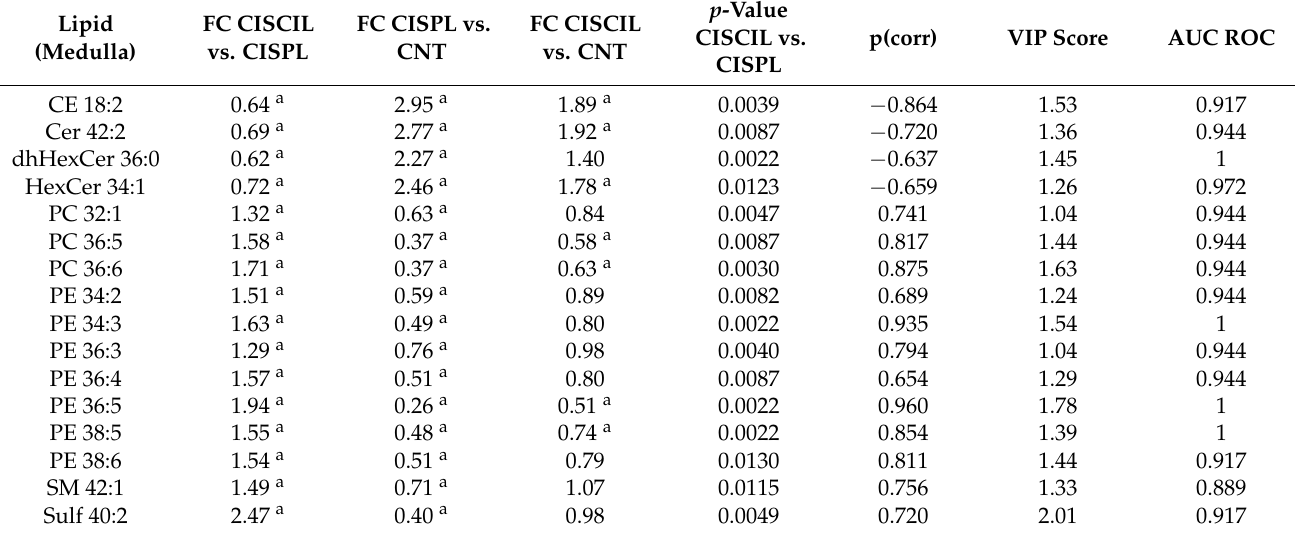
Table 5. Selected medulla lipids that are potential biomarkers of cilastatin nephroprotection. The CISCIL group was compared with the CISPL group. p -values from univariate analysis are considered. FC and AUC from the ROC are included. Lipids with a p -value < 0.05, FDR < 0.1, |p(corr)| > 0.5, and VIP score > 1 from the OPLS-DA model are